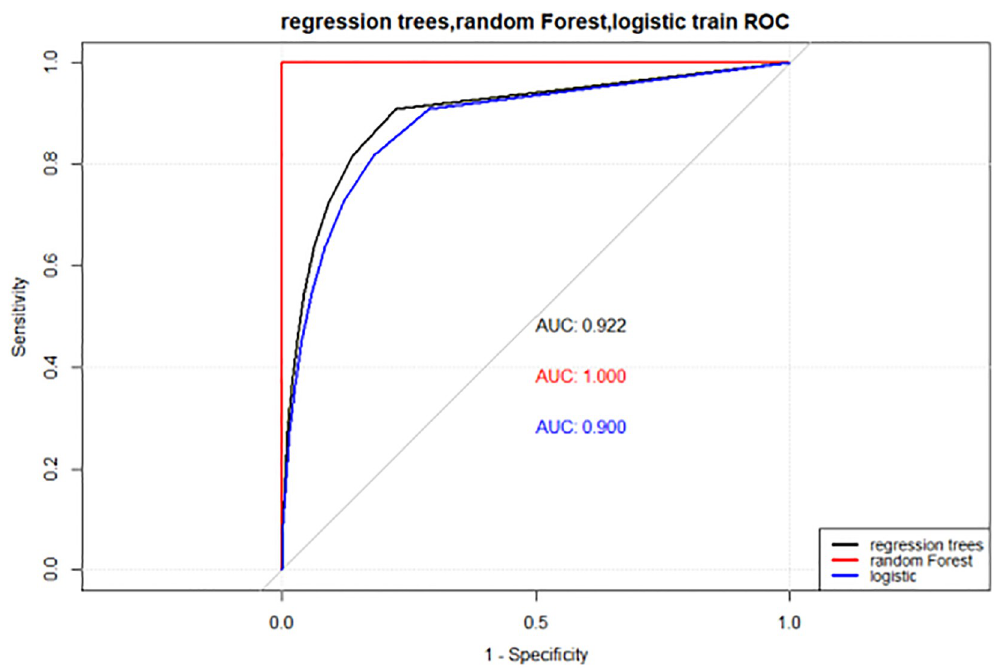
Fig 3. ROC curves of logistic, decision tree and random forest models in the training set.